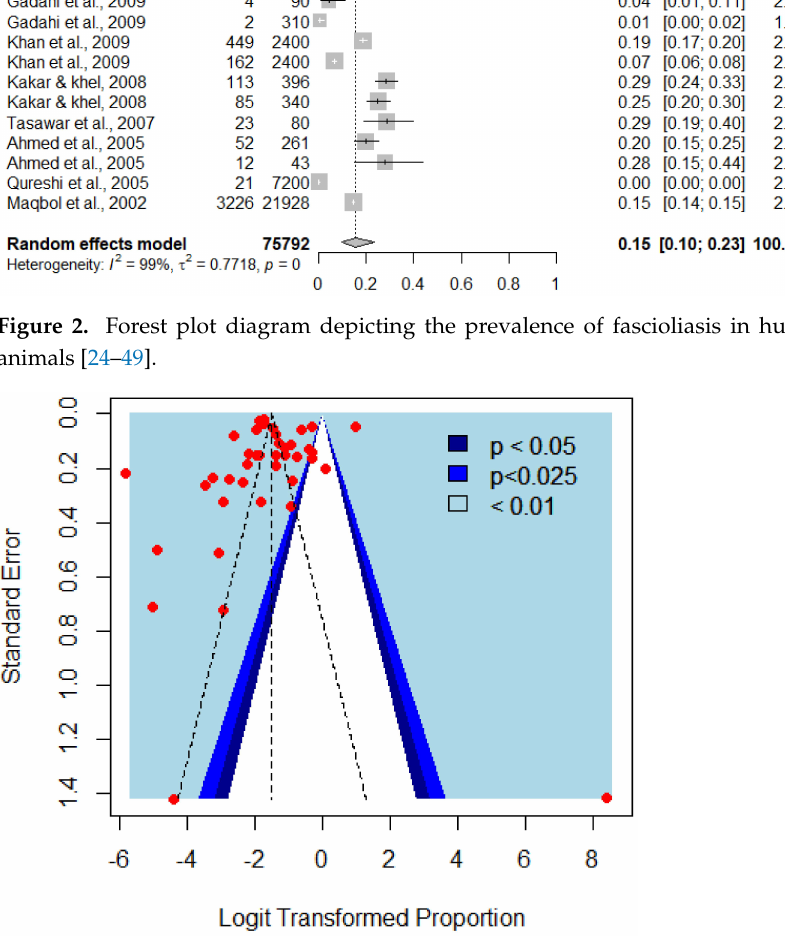
Figure 3. Funnel plot for studies included in the